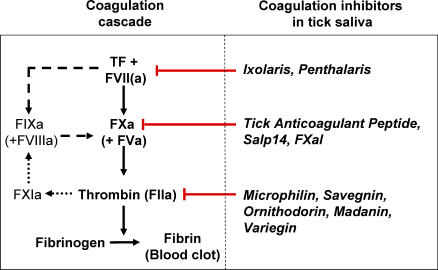
Schematic Overview of the Coagulation CascadeThe two major amplification loops in the coagulation cascade are depicted. The first amplification loop consists of TF-FVIIa-mediated factor IX (FIX) activation, which leads to the generation of more FXa. A second amplification loop is formed by the activation of factor XI (FXIa) by thrombin, which results in more activated FIX (FIXa), and, subsequently, additional FXa generation. The right panel indicates how selected tick proteins exert their anticoagulant effect.FIIa, activated factor II; FVa, activated factor V; FVIIIa, activated factor VIII.